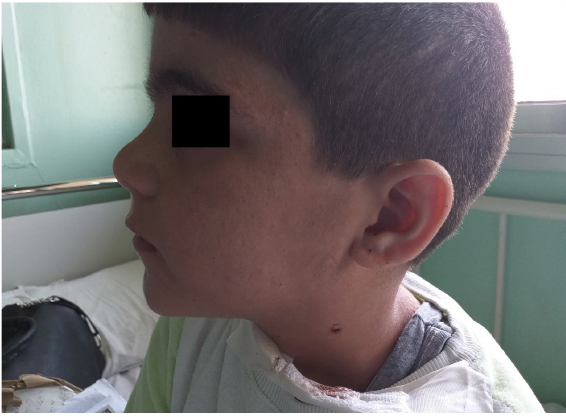
Figure 3. The Imporved Skin Lesions and Cold